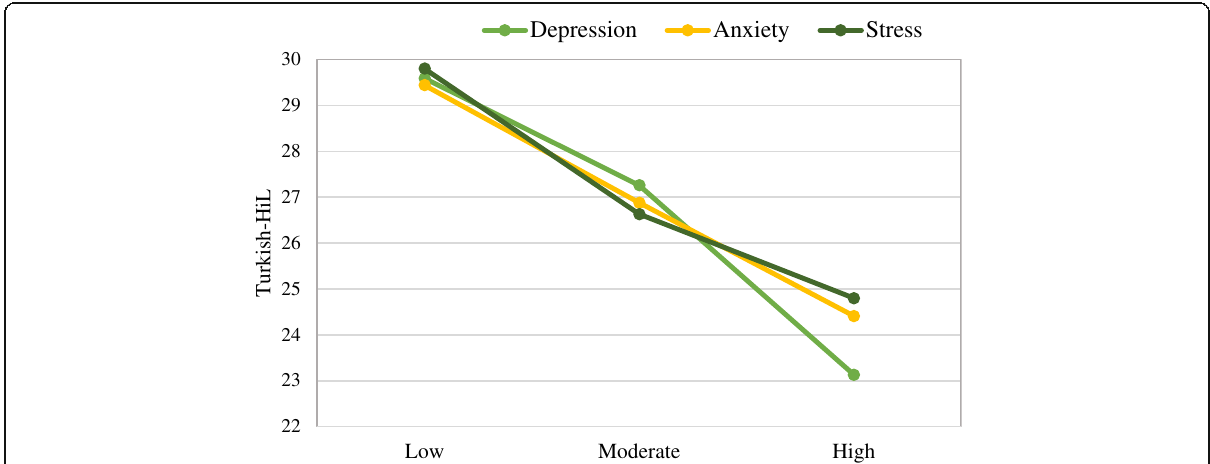
Fig. 1 Mean levels of depression, anxiety, and stress on the Turkish-HiL for participants with low, moderate, and high levels (significant differences observed)